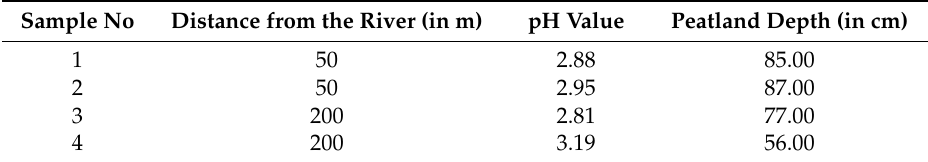
Table 2. Peatland depth profile and pH value of the study plots in Buntoi research site in Pulang Pisau, Central